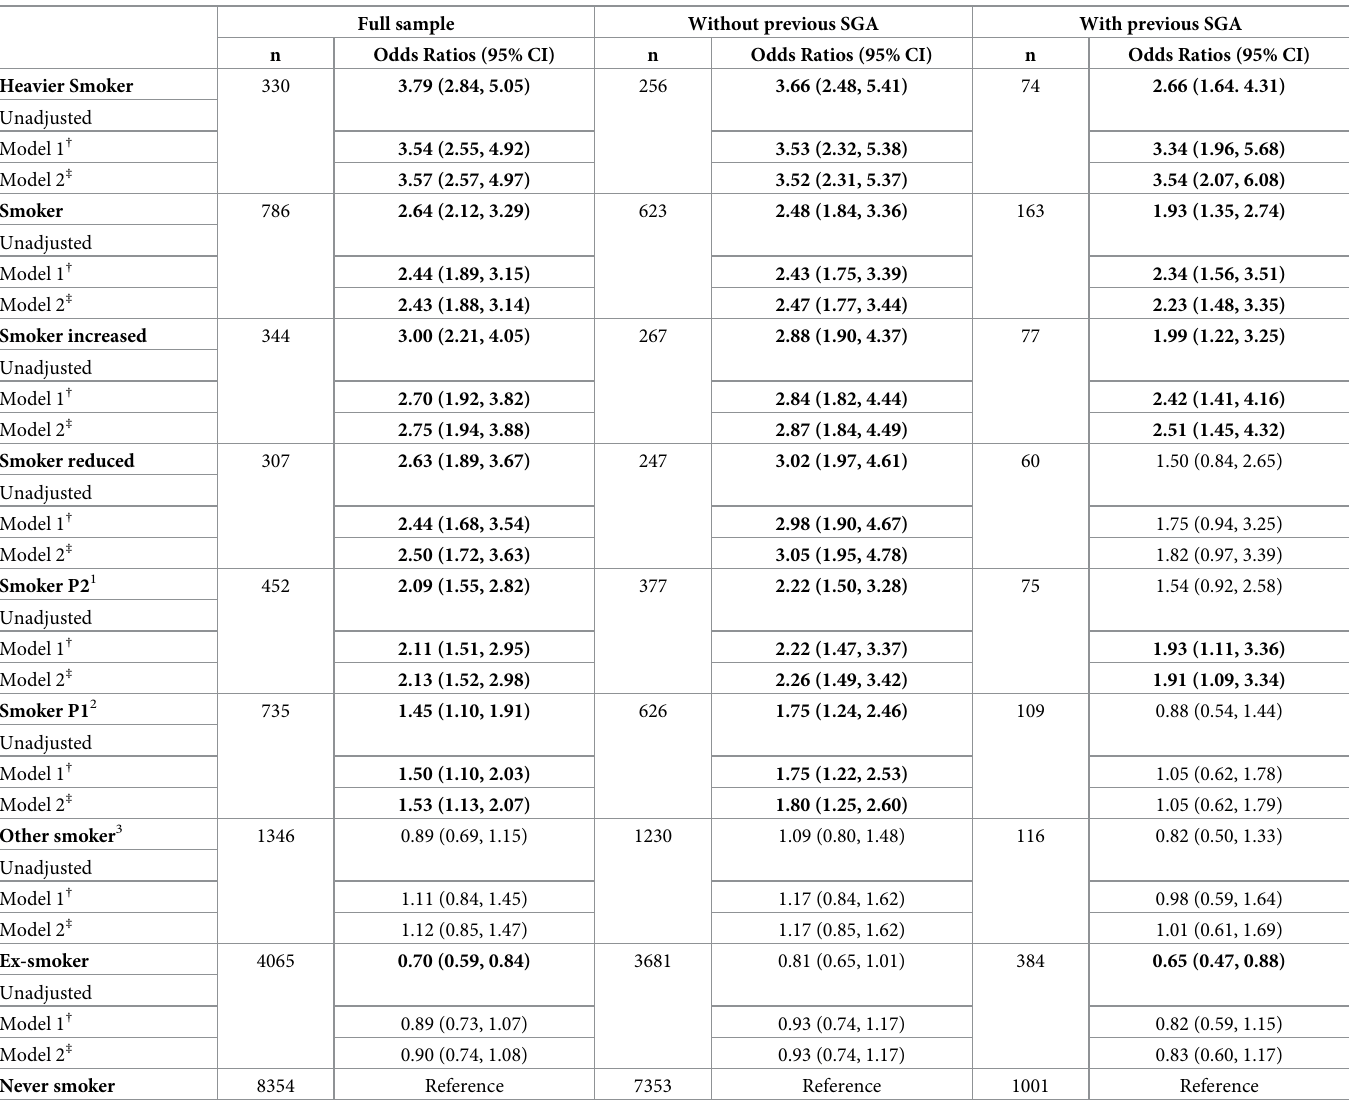
Table 4. The odds of small for gestational age birth ( < 10th percentile) in the second